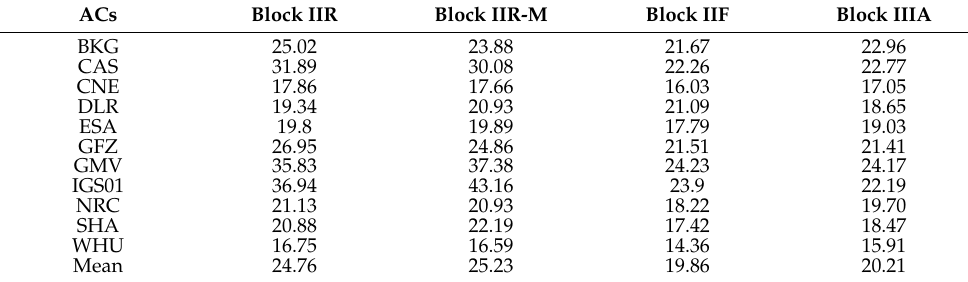
Figure 6. Scatterplots of IGS-RTS clock errors: PRN 16, Block IIR ( a ); PRN 29, Block IIR-M ( b ); PRN 30, Block IIF ( c ); and PRN 14, Block IIIA ( d ). Table 2. Clock error STD arranged by Block (ps).